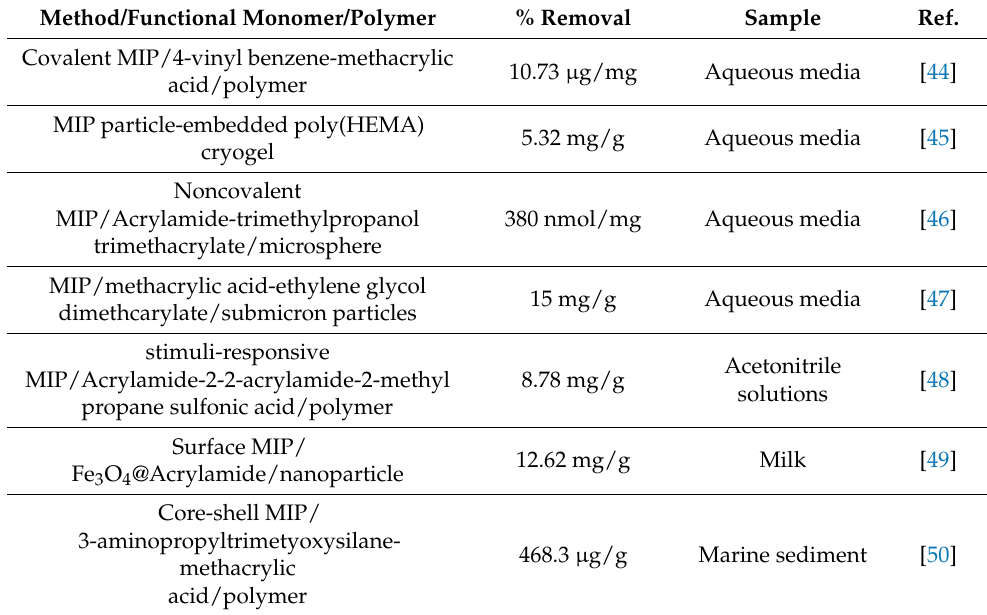
Table 5. Comparison of removal capacity of E2 with different E2-imprinted